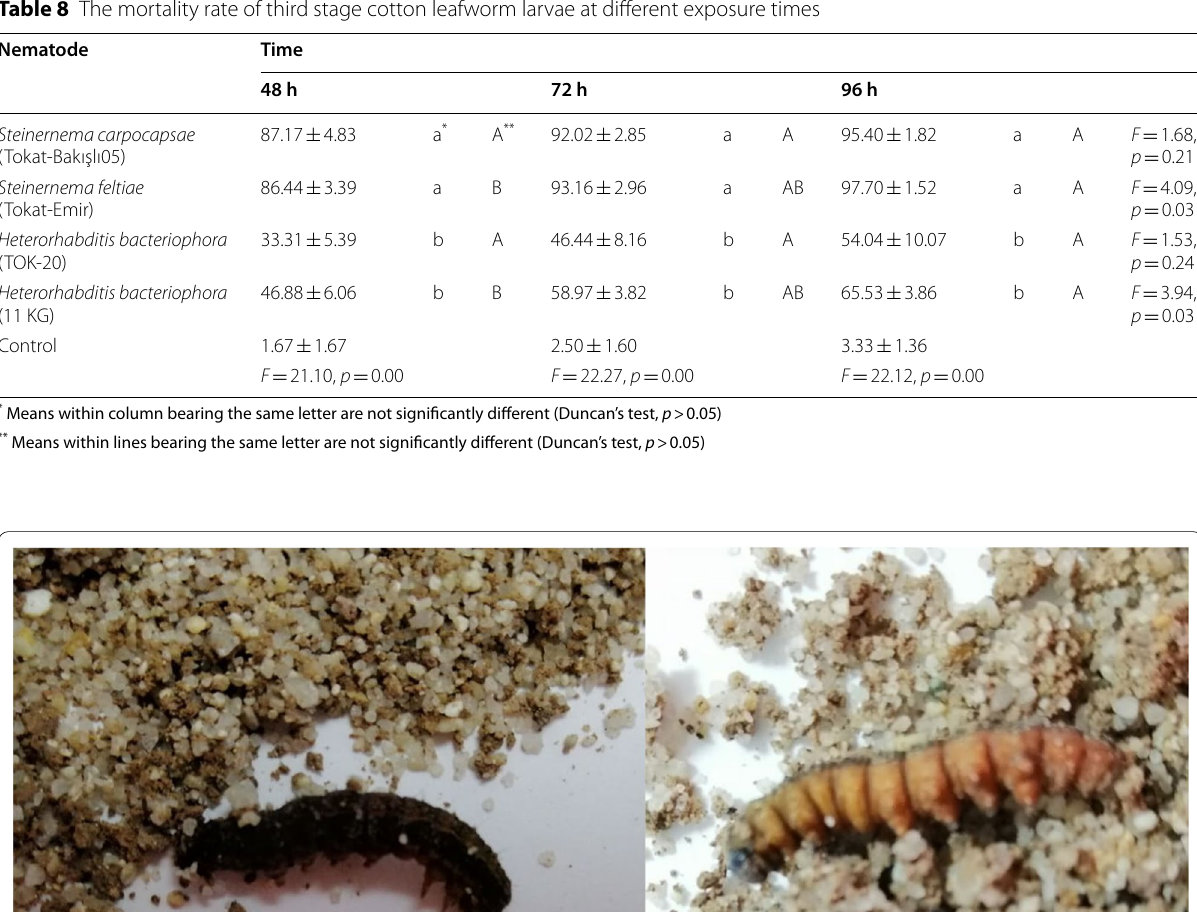
* Means within column bearing the same letter are not significantly different (Duncan’s test, p > 0.05) ** Means within lines bearing the same letter are not significantly different (Duncan’s test, p > 0.05)